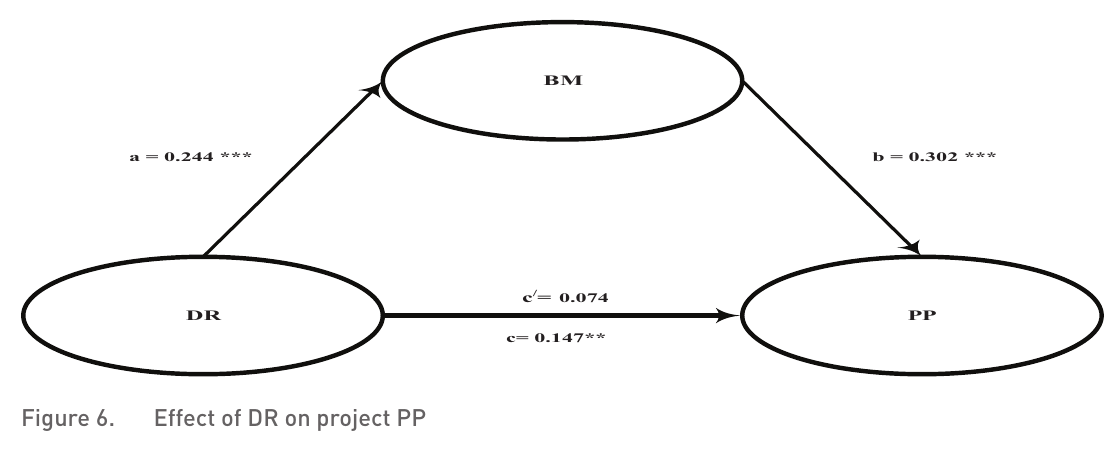
Figure 6. Effect of DR on project